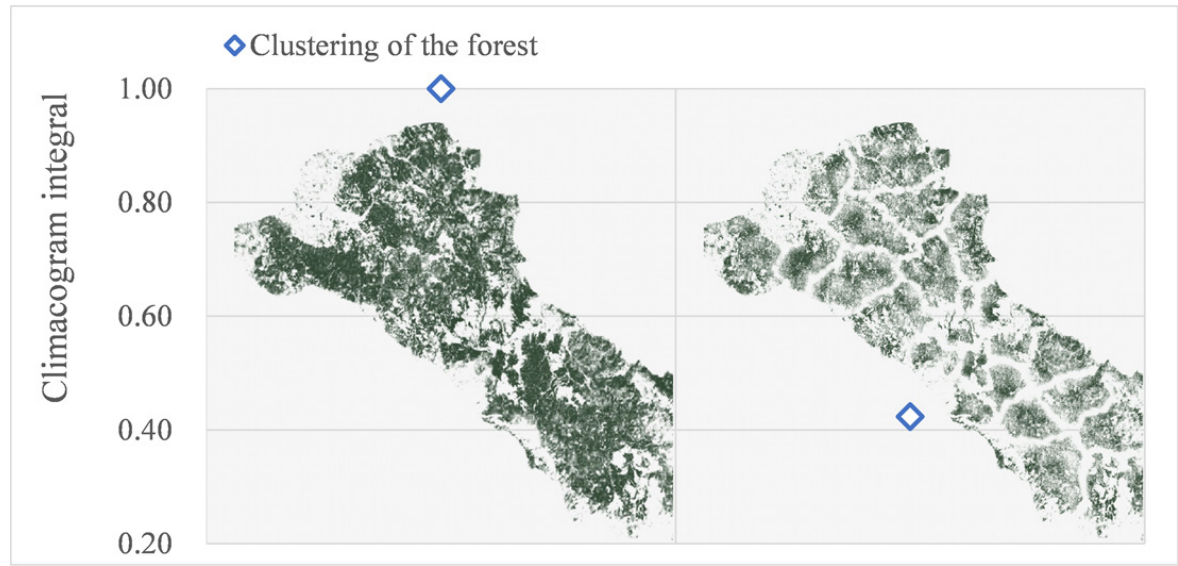
Figure 6. On the left, the clustering of the forests before the fire; on the right, a theoretical partitioning of the forest with SCFZs.